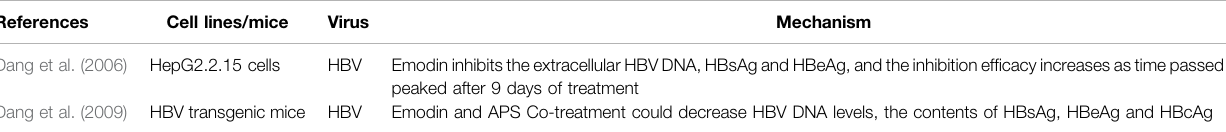
TABLE 5 | Anti-HBV activities of